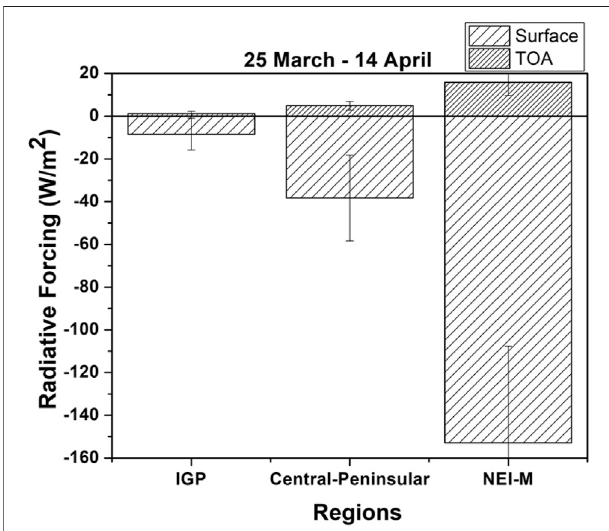
FIGURE 5 | Radiative forcing at the top of the atmosphere (TOA) and at the surface over central India, the Northeast-India-Myanmar region (NEI-M), and IGP. Vertical bars indicate standard